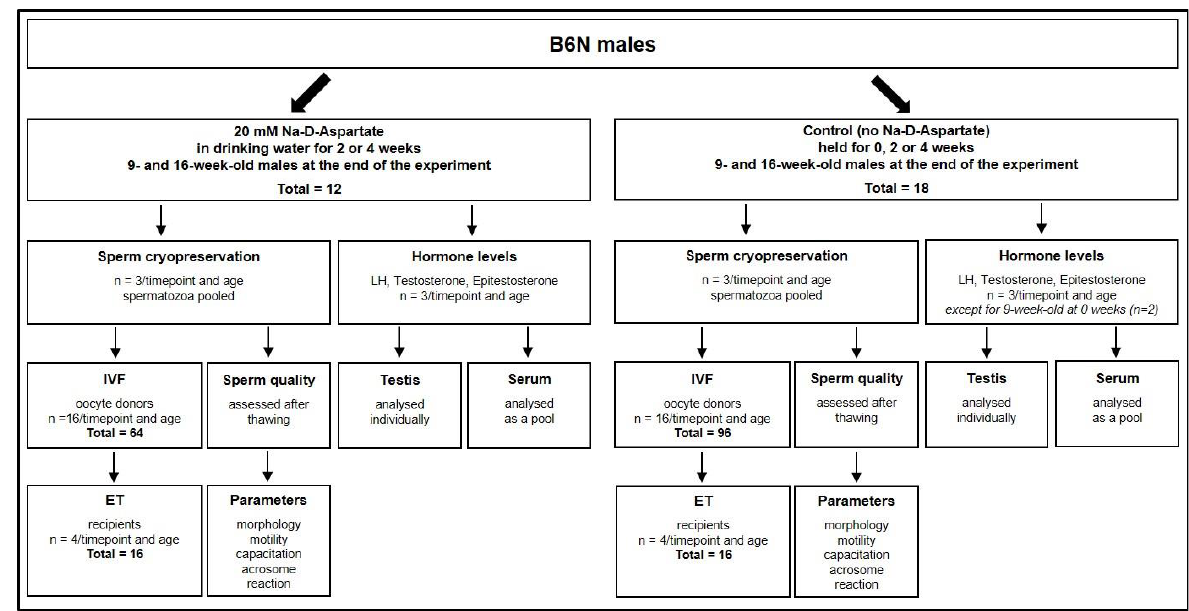
Figure 1. Experimental design of the study. LH: Luteinizing Hormone. IVF: In Vitro Fertilization. ET: Embryo Transfer.